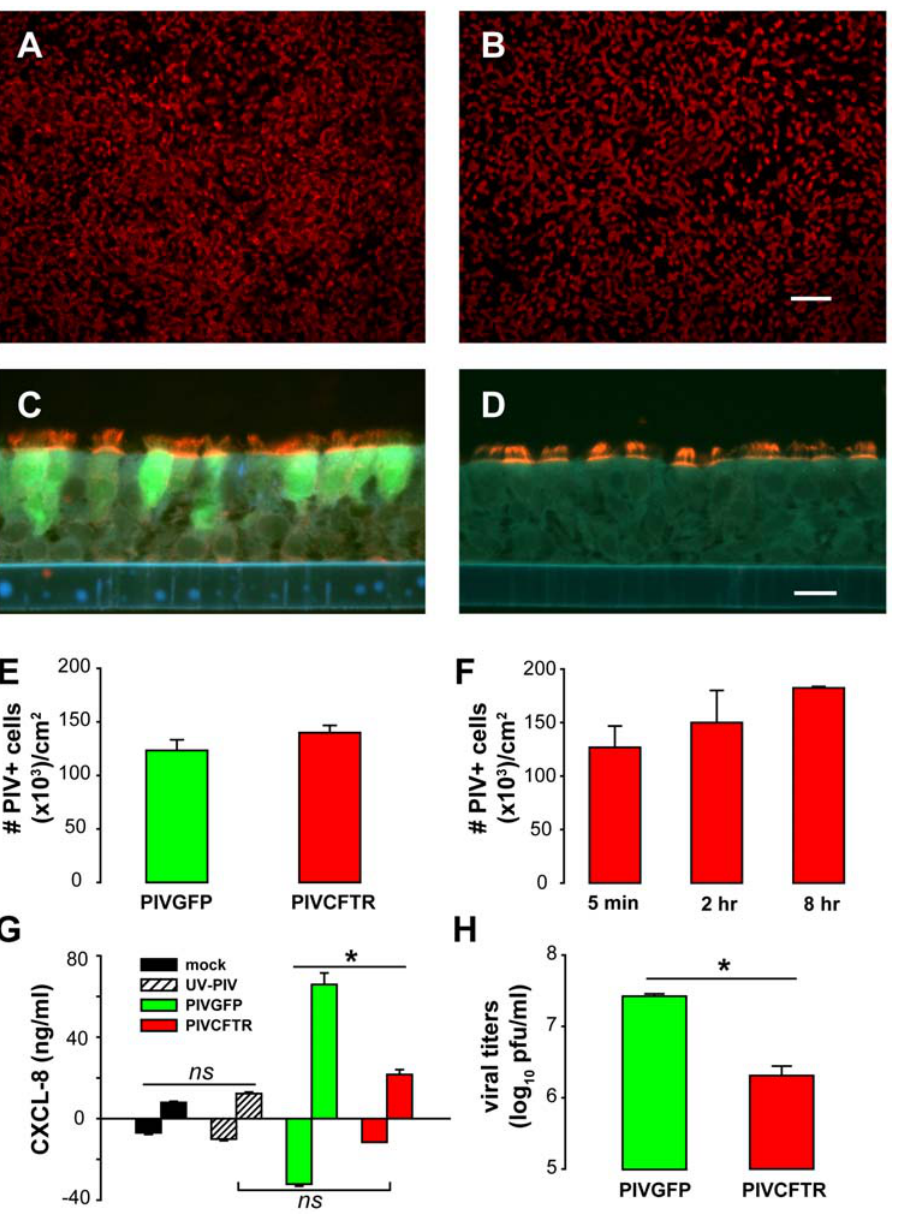
Figure 2. Efficient targeting of CF ciliated cells by PIVCFTR. (A–D) Representative immunodetection of human PIV fusion (F) glycoprotein (red) (A and B) en face or (C and D) in histological sections of CF HAE 48 h pi with PIVGFP (A and C) or PIVCFTR (B and D). F glycoprotein was detected by indirect immunofluorescence with a murine monoclonal anti-F Ab and anti-mouse IgG conjugated to AlexaFluor 594 (red). GFP-positive cells were identified in histological sections (C), using rabbit anti-GFP conjugated to fluorescein (green). Fluorescence was viewed using a Texas Red filter only (A and B) or a combined Texas Red-FITC-UV-filter (C and D). Bars represent 200 m m and 10 m m for (A and B, and C and D), respectively. (E and F) Quantitation of (E) numbers of PIV F-positive ciliated cells showing that PIVGFP and PIVCFTR infect similar numbers of ciliated cells at 48 h pi ( n =8); and (F) the efficiency of ciliated cell infection by PIVCFTR assessed at 24 h was similar with 5-min, 2-h, or 8-h inoculation times ( n =6). (G) CXCL8 protein levels secreted by HAE 48 h pi with mock, UV-inactivated PIV, PIVGFP, or PIVCFTR showing reduced levels for PIVCFTR versus PIVGFP. Responses positive/negative of the abscissa reflect CXCL8 secretion into apical/basolateral compartments, respectively ( n =5 for each). (H) Viral titers in apical compartment at 48 h pi for PIVGFP (green) and PIVCFTR (red) showing attenuated growth of PIVCFTR ( n =5 for each). An asterisk (*) denotes p , 0.05; ns, not significantly different. Error bars indicate SEM .